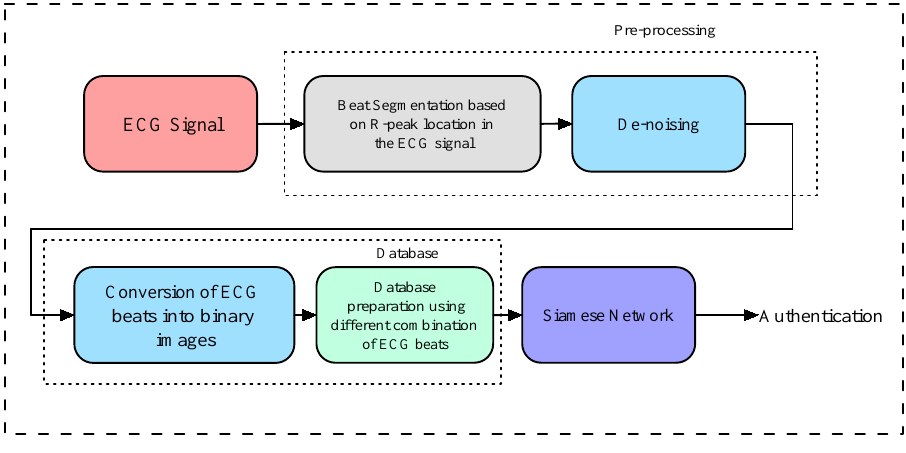
Figure 1. Block diagram of the proposed biometric authentication system.